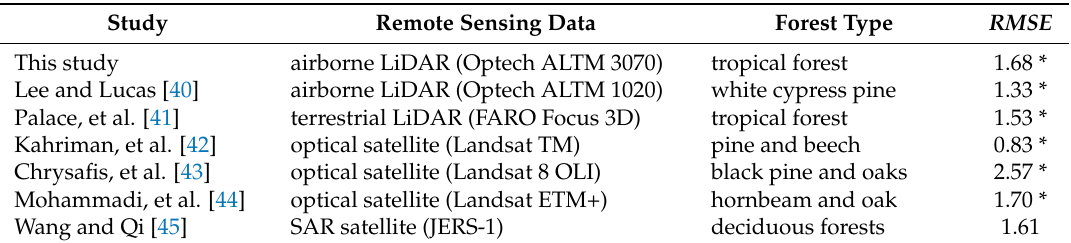
Table 4. Results of stand density estimation obtained from other studies. The minimum RMSE (trees/100 m 2 ) values were selected and denoted by * if the study reported multiple